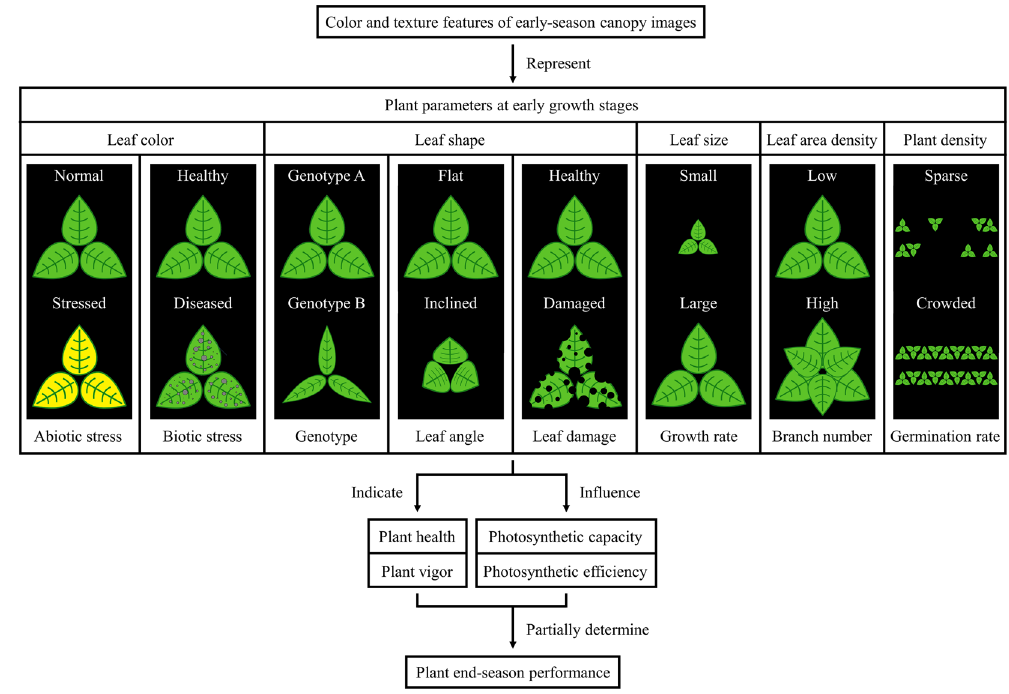
Figure 9. Schematic diagram explaining the potential relationships between color and texture information of early-season canopy images and end-season plant